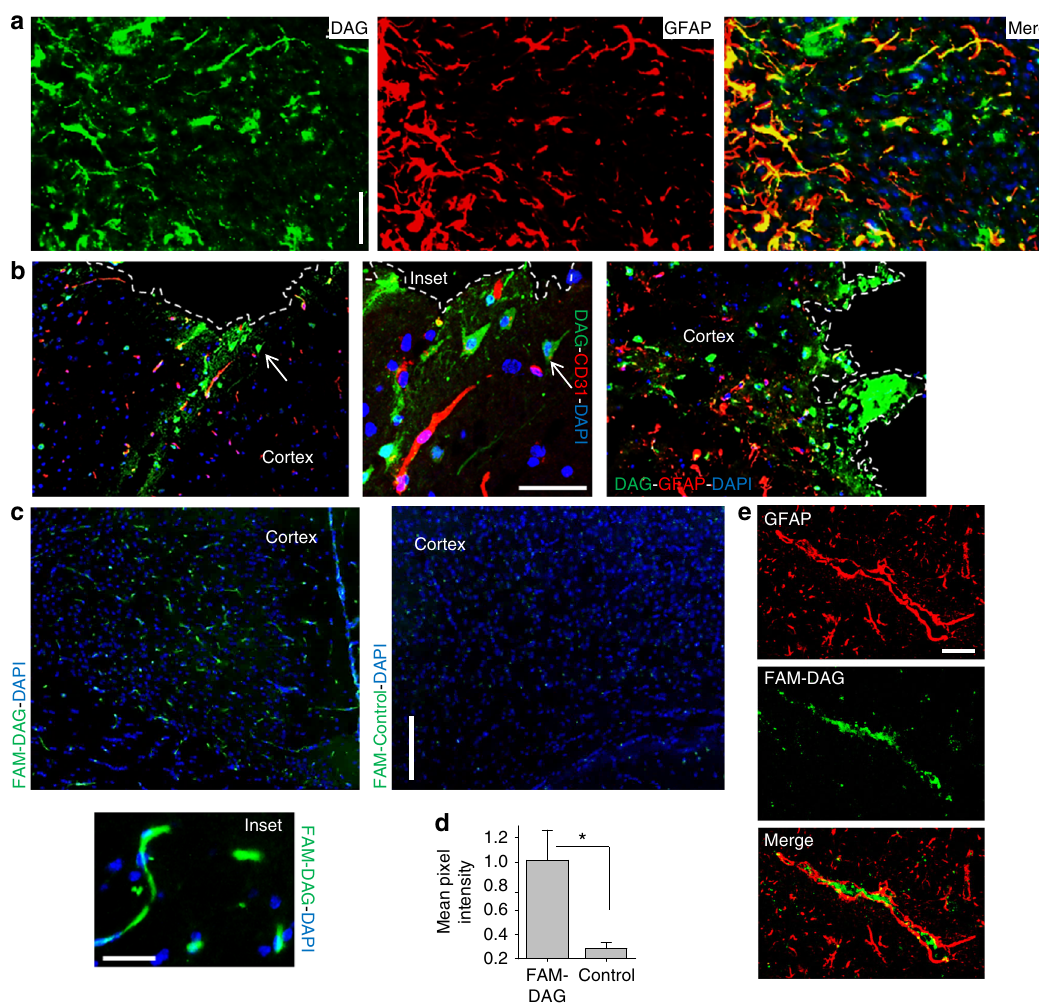
Fig. 6 DAG homes to the brain in mouse models of neuroin fl ammation. a DAG targets brain in mouse model of glioblastoma. FAM-DAG was intravenously injected to mice bearing an angiogenic glioblastoma derived from a patient (P13), and allowed to circulate for 30 min, after which the mice were perfused, the tumors were fi xed, sectioned and stained for FAM ( green ), and GFAP ( red ). Scale bar , 40 µ m. b DAG homes to acute brain injury in mice. FAM-DAG was injected intravenously in mice with penetrating brain injury, processed as in panel a . Representative immuno fl uorescence images of brain sections from the injury area stained for FAM ( green ), and CD31 ( red ; left and middle panels ) or GFAP ( red ; right panel ) show stellate-shaped cells positive for DAG (see arrow ). Scale bar , 40 µ m. c – e DAG homes to the brain in a Parkinson ’ s disease mouse model. FAM-labeled DAG or control peptide was intravenously injected to Parkinson ’ s disease mice (mTHY-1- α -synuclein model, 1-year old) and processed as in panel a . c Brain sections were stained for FAM ( green ) and counterstained with DAPI Scale bar , 100 μ m. Inset shows a typical worm-like structure targeted by DAG in the cortex. Scale bar , 20 μ m. d Fluorescence signal from FAM in panel c was quanti fi ed using ImageJ. e Brain sections from DAG-injected mice were stained for FAM ( green ) and GFAP ( red ). DAG signal associates with activated astrocytes. Scale bar , 40 µ m. * P <